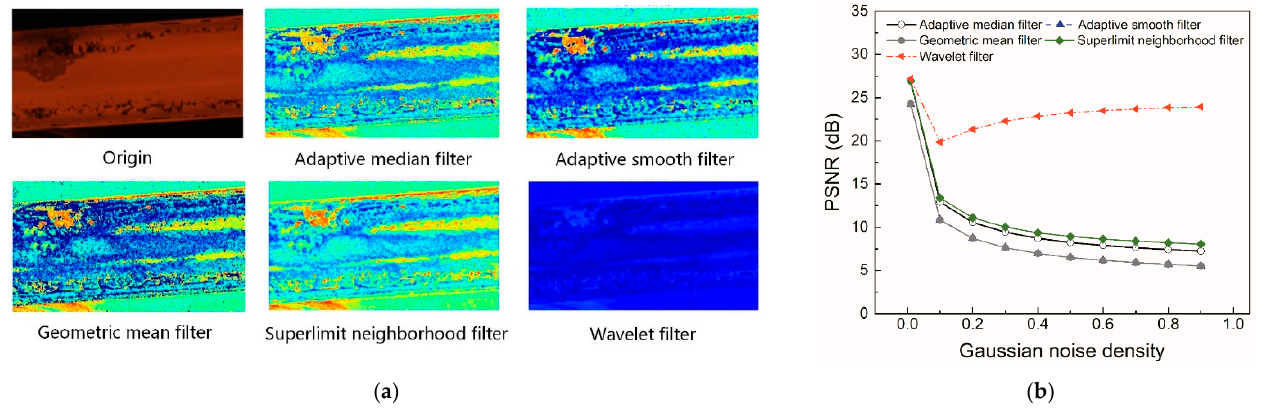
Figure 5. The noise filtering results of rail steel plates radiation images (online version in color): ( a ) results for different filtering methods; ( b ) PSNR . ( a ) results for different filtering methods; ( b )